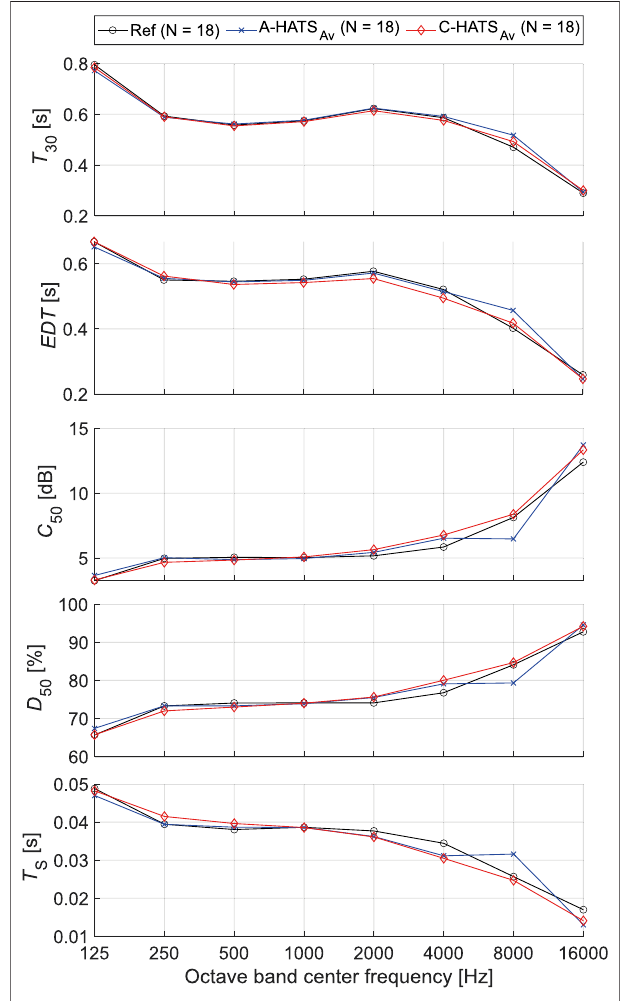
FIGURE 4 | Room acoustic parameters according to the different measurement methods: omnidirectional microphone (Ref), adult and child HATSs with the averaging method (A-HATS Av /C-HATS Av